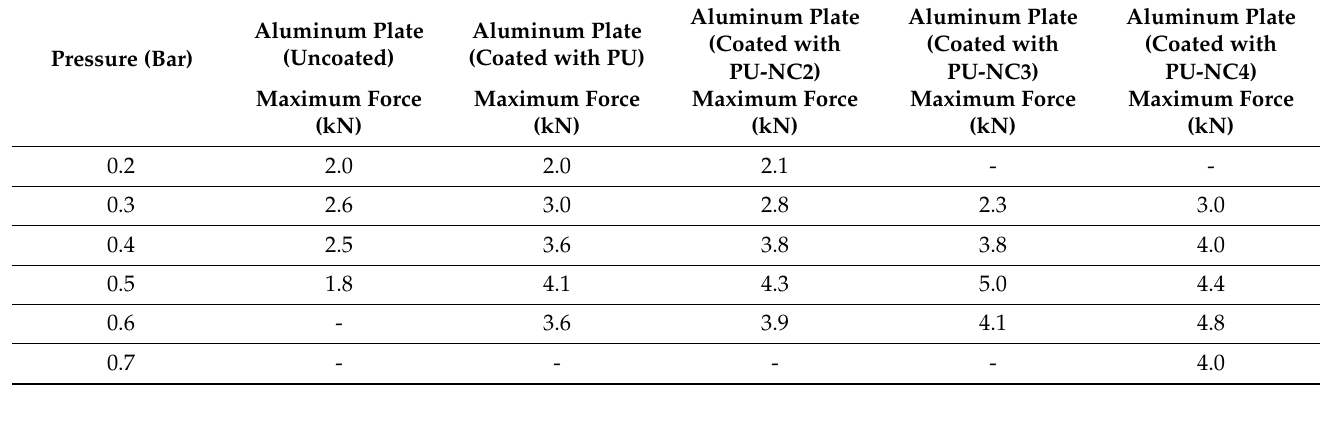
Table 6. Maximum force values obtained during the impact tests with Hopkinson bar.